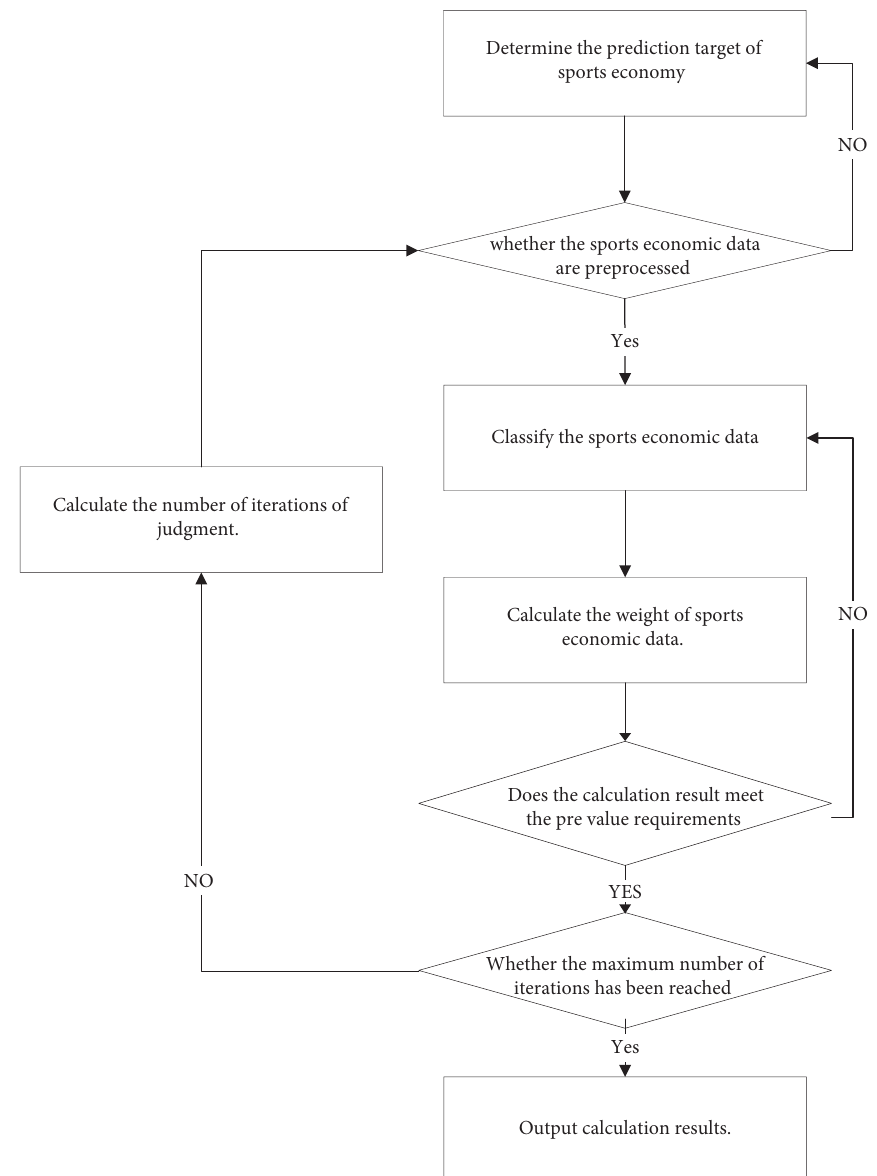
Figure 2: The flowchart of the improved artificial bee colony